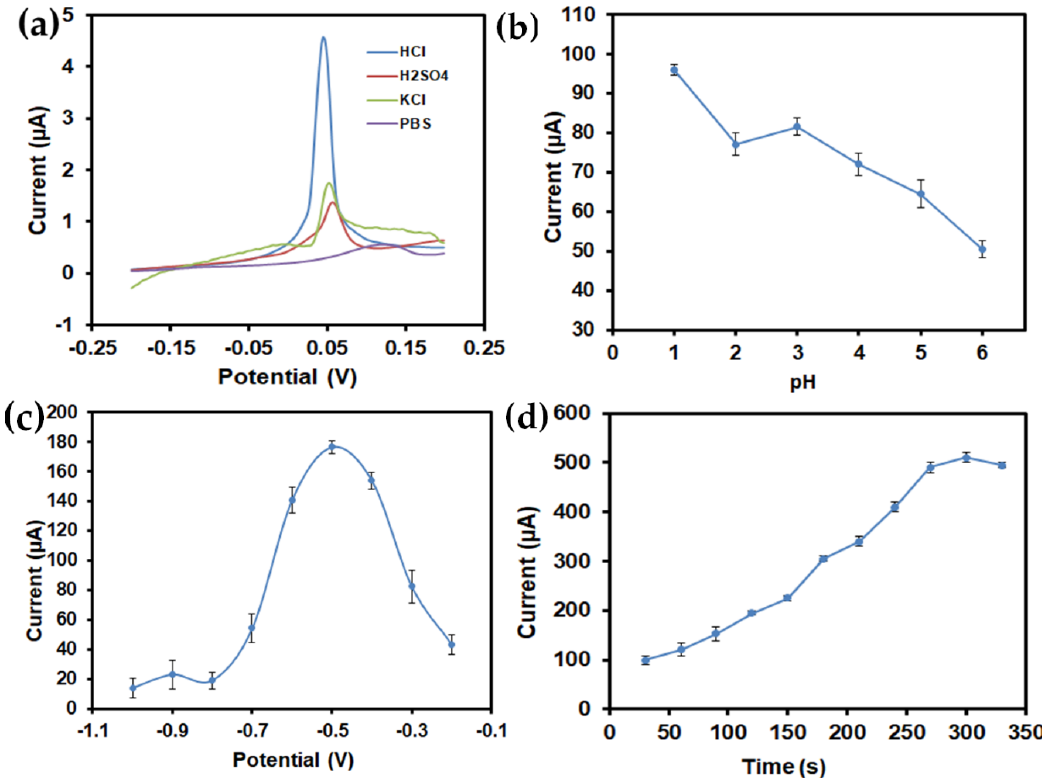
Figure 6. Effect of the ( a ) supporting electrolyte, ( b ) pH, ( c ) deposition potential, and ( d ) deposition time on the voltammetric response of the SiNPs/SPCE in the presence of 1 mg/L As(III).